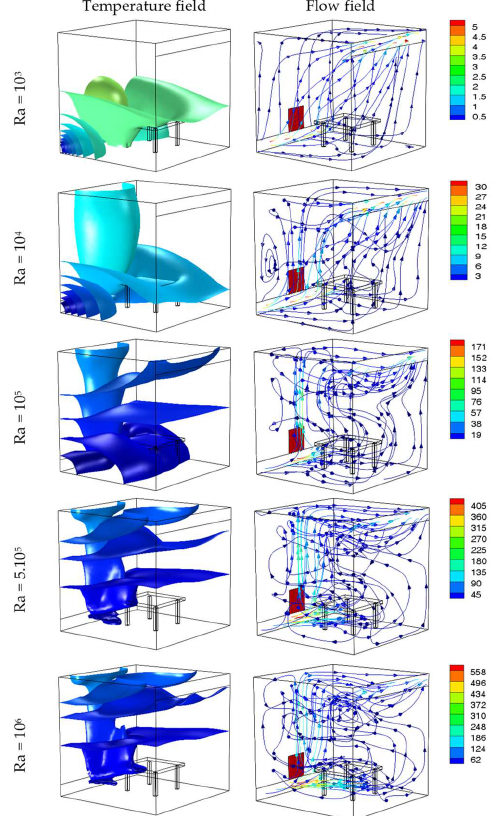
Figure 6. Effect of Rayleigh number variation on the distribution of temperature iso-surfaces and particle trajectories for a heat source position as indicated in case 2.